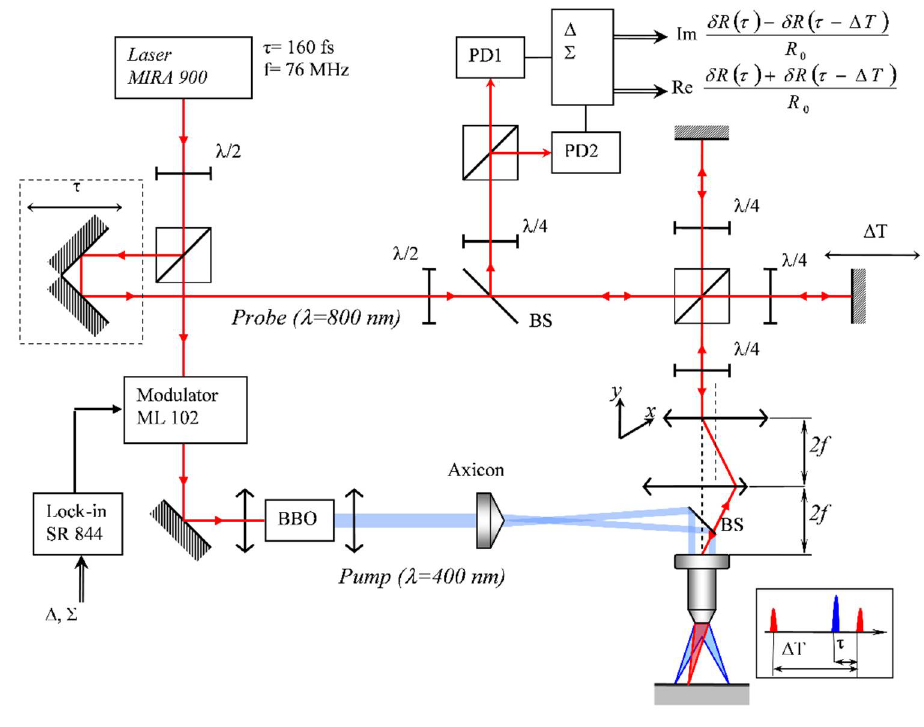
Figure 1. Experimental setup.